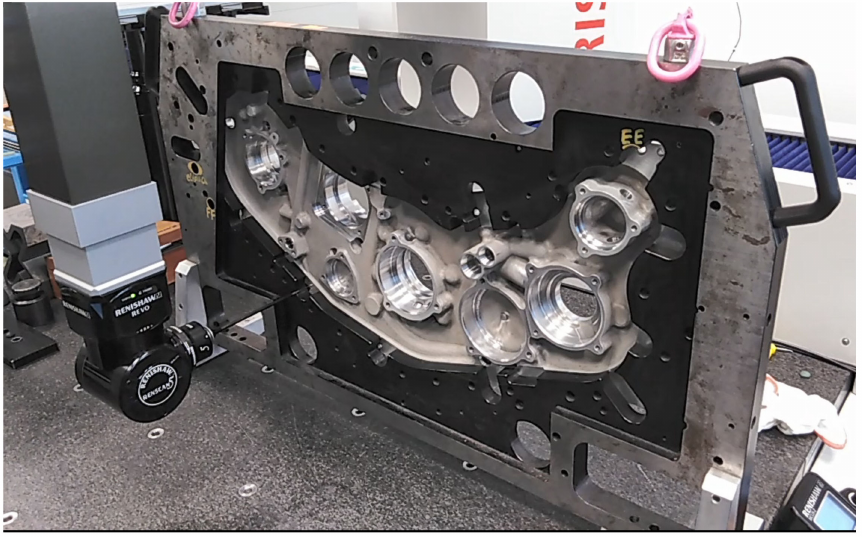
Figure 6. Cover measurement in the measurement laboratory using a CMM.